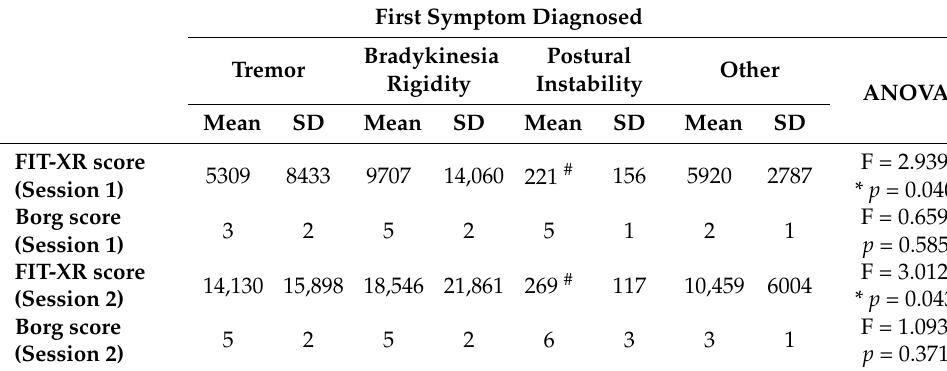
Table 5. Relationship between the first symptom diagnosed and VRI task